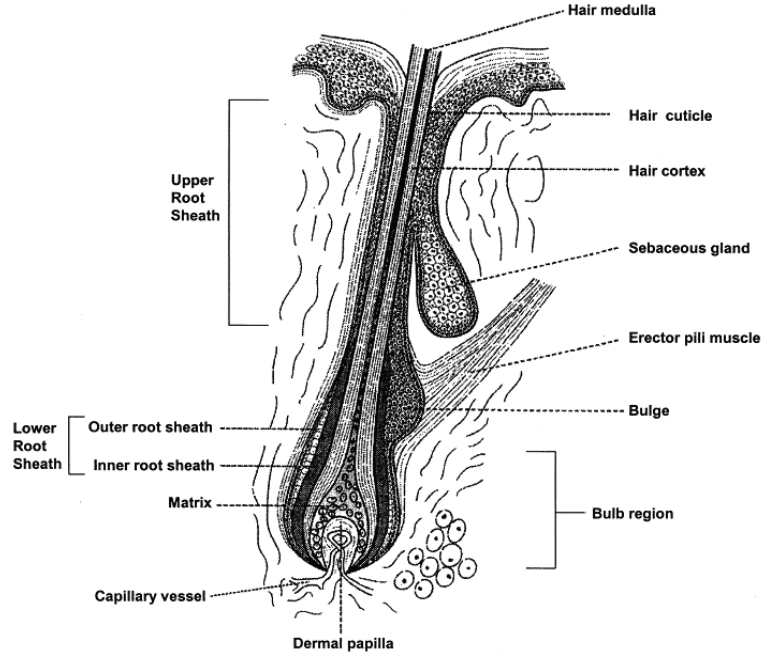
Figure 1. Hair shaft and follicle anatomy. Reprinted with permission from [7], published by Oxford University Press,